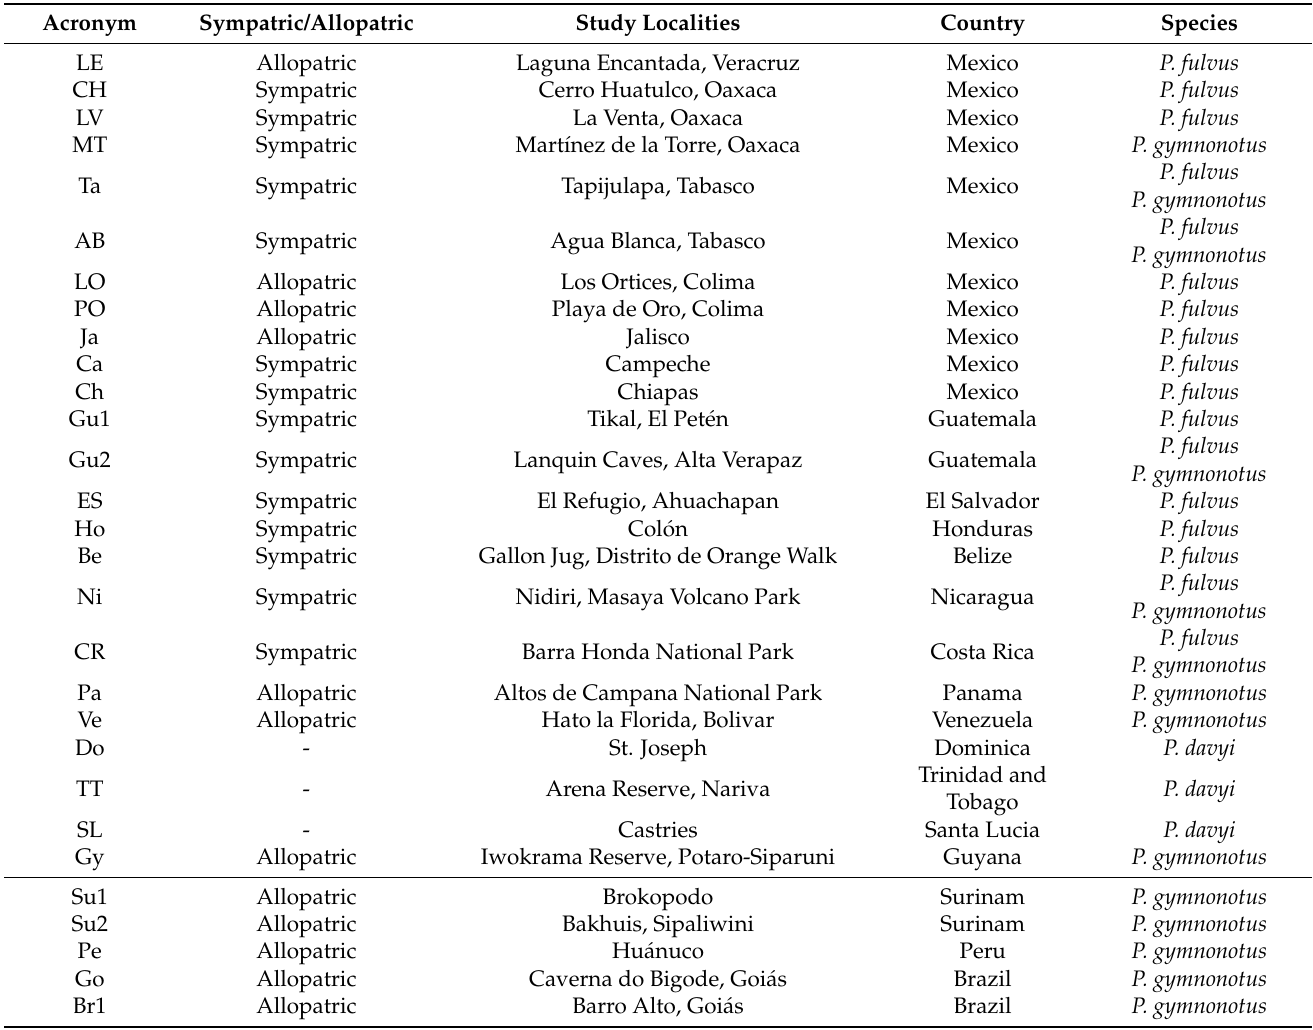
Table 1. Study localities. The allopatric and sympatric localities of P. fulvus and P. gymnonotus are mentioned.